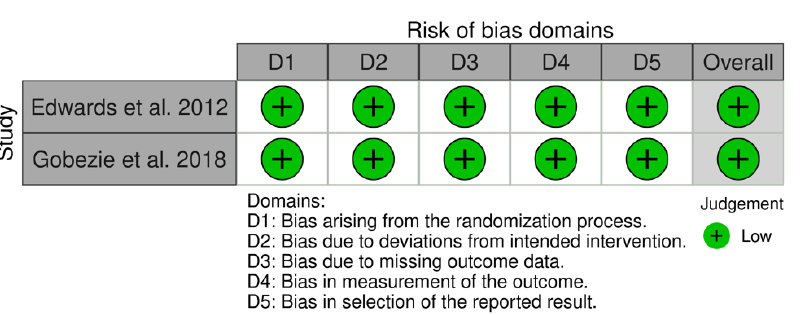
Figure 3. The risk of bias assessments for NRCTs studies [26,27,35,36,40–42]. Figure 4. The Joanna Briggs Institute critical appraisal tool for CS studies [25,39].